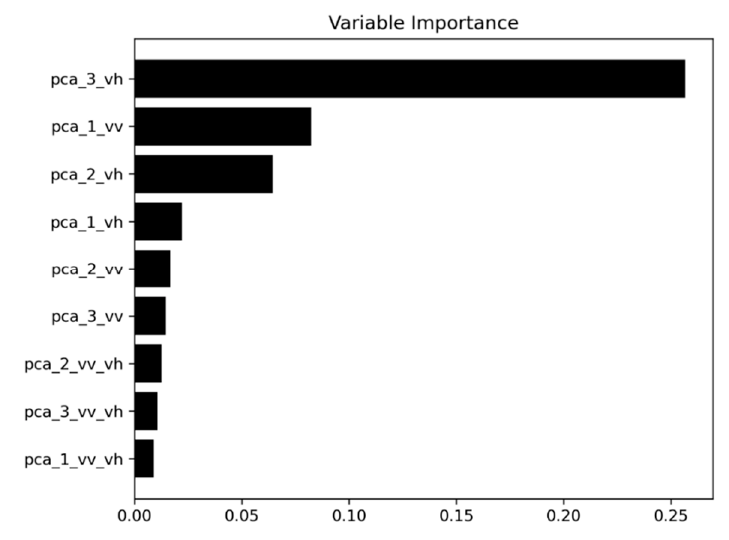
Figure 5. Permutation importance scores for the Principal Component Analysis (PCA)-derived images used in the analysis. PCA 3 for the VH polarization is the most important variable in our study. The same results were obtained for the two estimators.